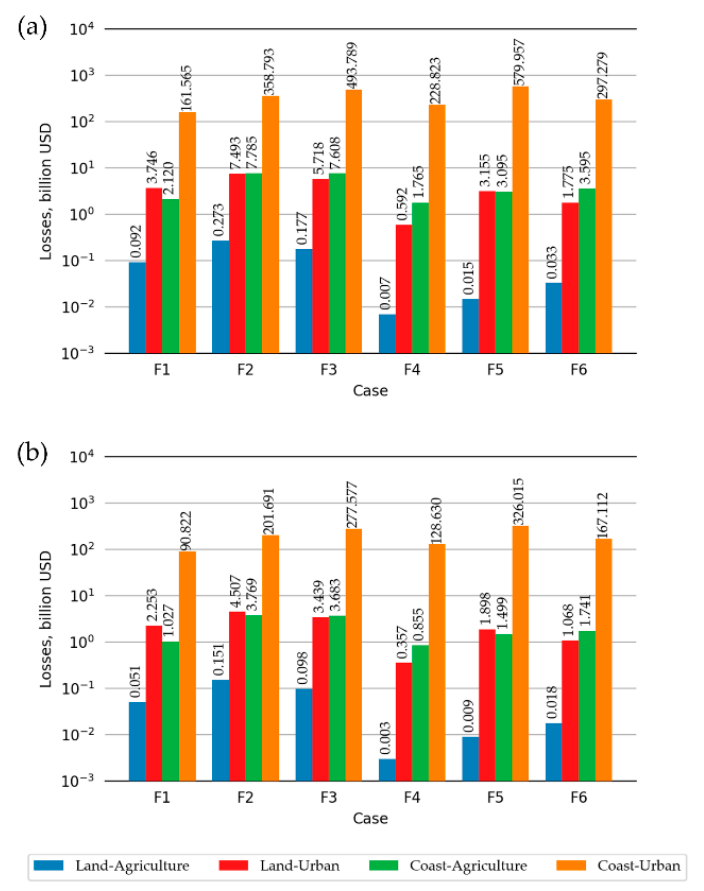
Figure 11. Economic losses in each tsunami case, ( a ) direct economic losses, ( b ) indirect economic losses.